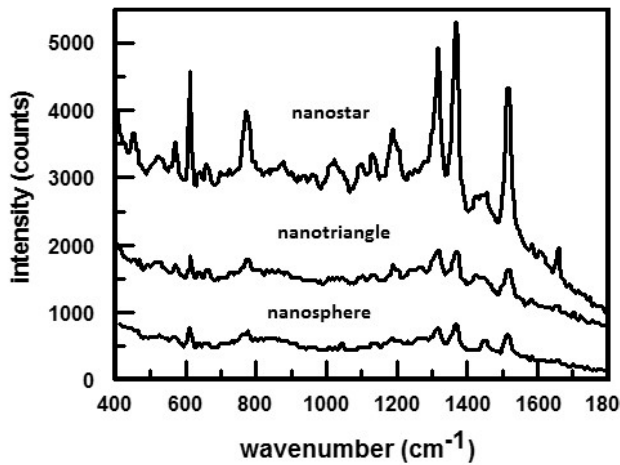
Figure 2. Comparison of 5 μ M rhodamine 6G SERS spectra in suspensions of gold nanostars, nanotriangles, and aggregated nanospheres. The SERS response was negligible for unaggregated nanosperes. SEM images of the nanostructures are shown in Figure 1. Spectra were obtained using a laser excitation of 785 nm. Reproduced with permission from Royal Society of Chemistry, 2014 [59].